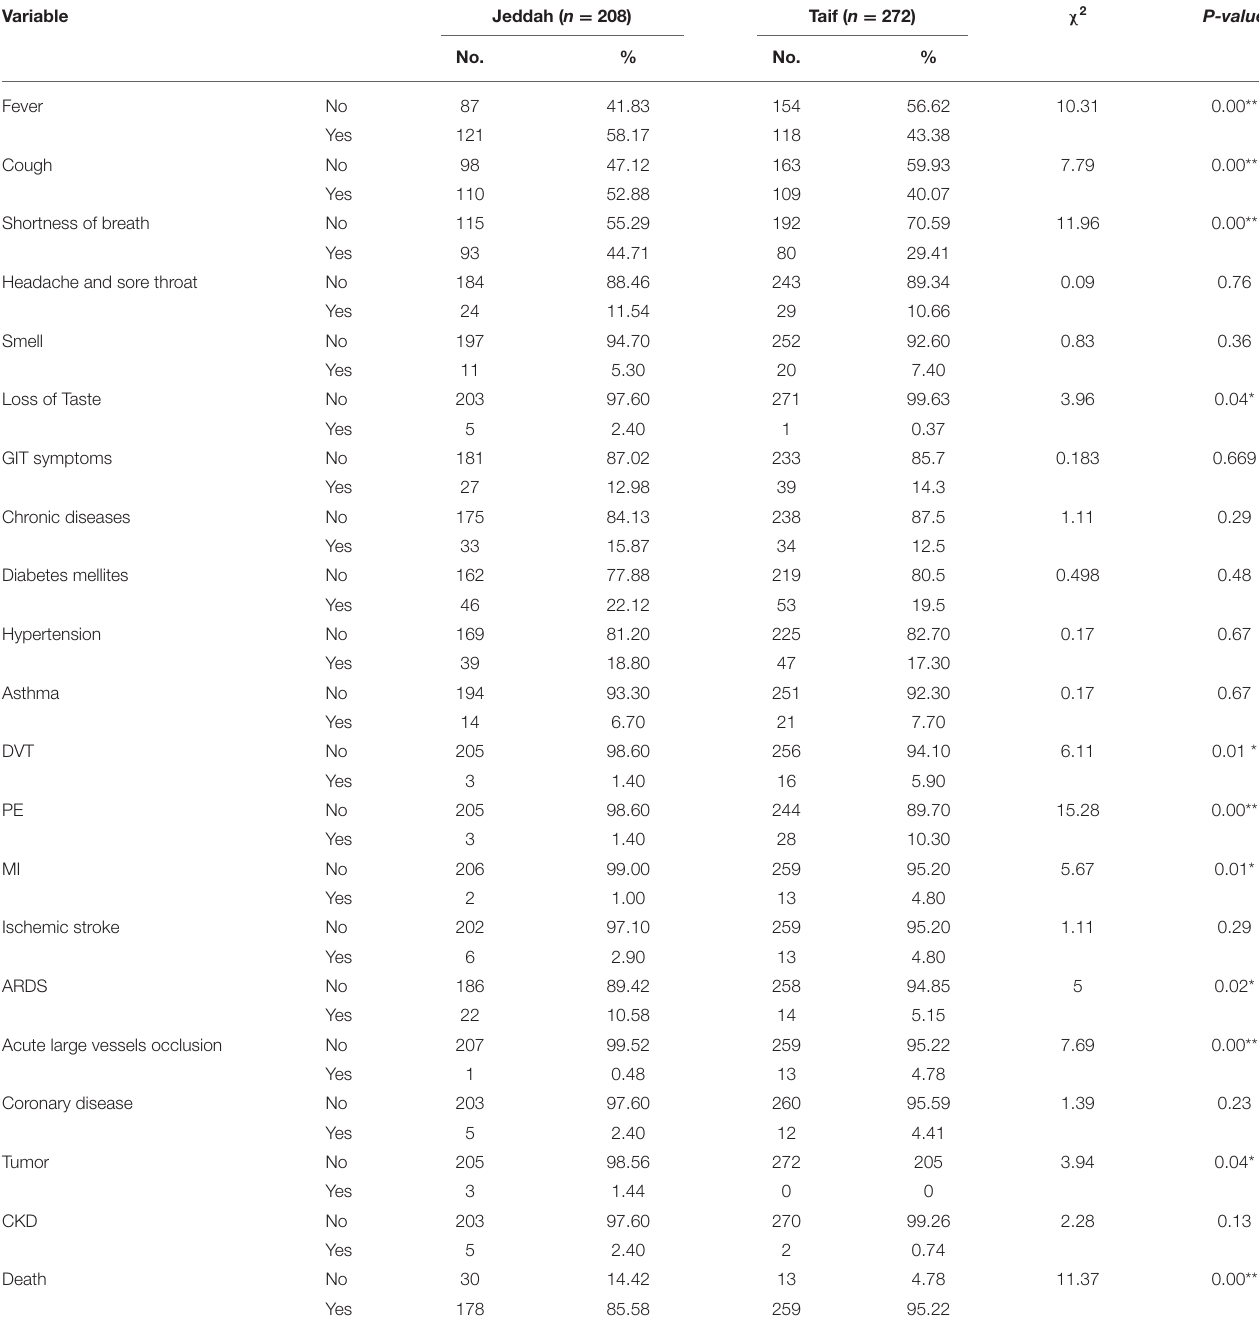
TABLE 7 | Clinical, laboratory and deaths among COVID-19 ICU patients in Jeddah and Taif. Variable Jeddah ( n = 208) Taif ( n = 272) χ 2 P-value